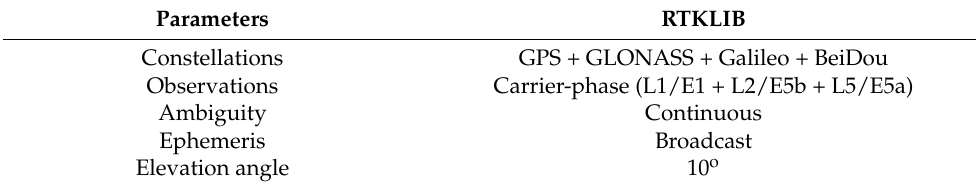
Table 9. Processing parameters used in